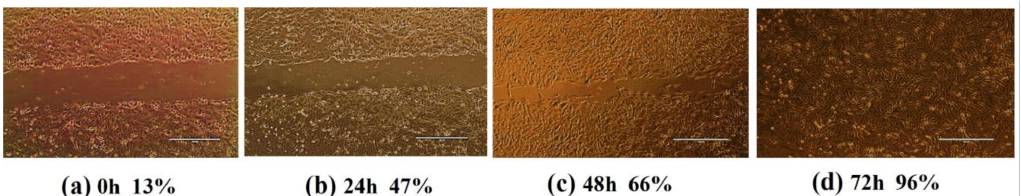
Figure 14. In vitro scratch wound-healing activity of AgNPs. ( a ) At the initial time, 0 h, this showed 13% cell migration in wounded scratches; ( b ) at 24 h, wound-healing activity started to increase with 47% cell migration; ( c ) at 48 h, it increased to 66%; ( d ) at 72 h, a wound-healing efficacy of 96% was observed under an inverted microscope. The scale bar is 500 µ m ( a – d